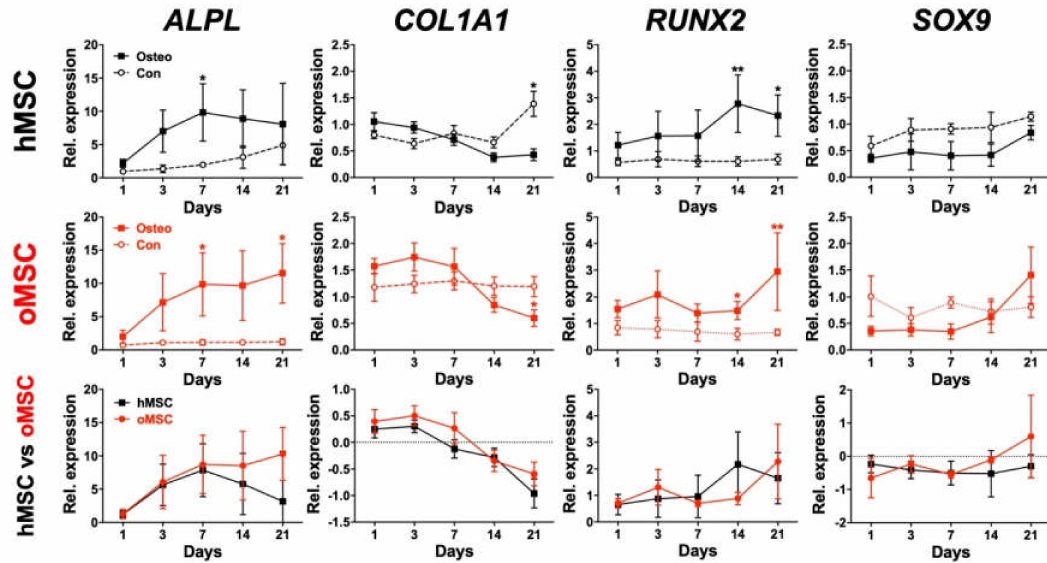
Figure 6. Expression dynamics of common osteogenic gene markers. Mesenchymal stromal cells (MSC) from osteoporotic (oMSC) and non-osteoporotic healthy control donors (hMSC) at passage 3–5 were induced towards the osteoblast lineage for 21 days. Culturing medium without any osteogenic induction supplement was used as control. The relative mRNA expression of ALPL , COL1A1 , RUNX2, and SOX9 was investigated at the indicated time points during the osteogenic di ff erentiation. Data analysis was performed using ddCT values normalized to GAPDH . Data are expressed as average ± SD of three to four donors per group. For a direct comparison of the hMSC vs. oMSC groups (bottom panels), non-induced samples were subtracted from induced MSCs to determine the delta expression level. * p < 0.05, ** p < 0.01, Mann–Whitney